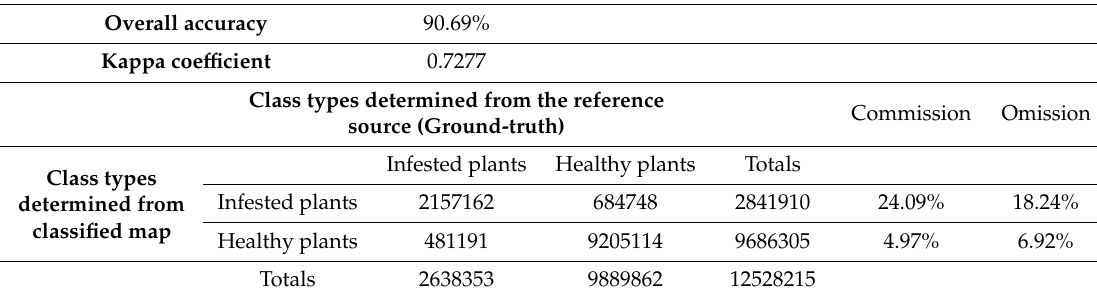
Table 1. A confusion matrix of k-means support vector machine (SVM) regional classification for Chase field.